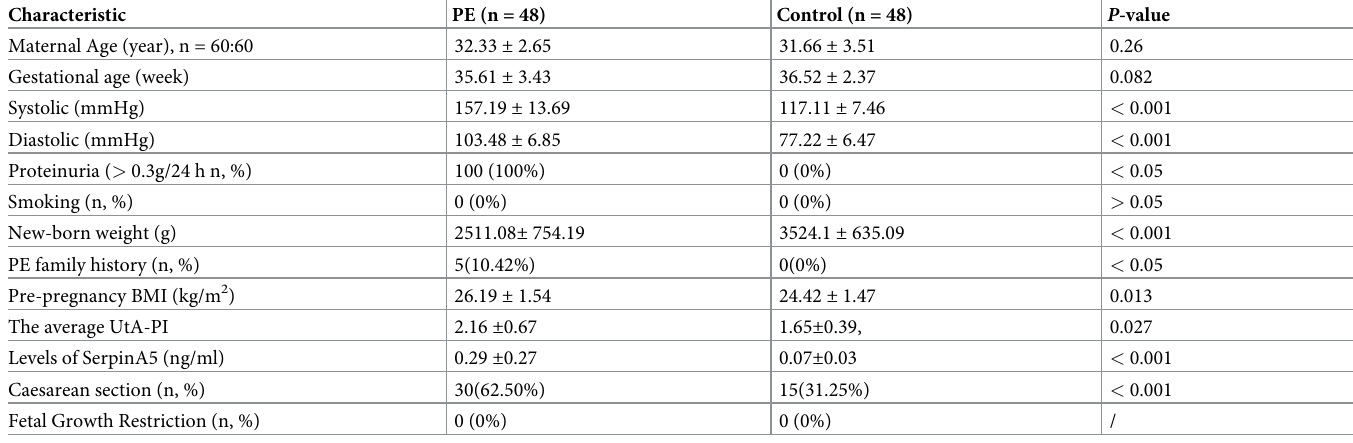
Table 1. Clinical characteristic of patients and control